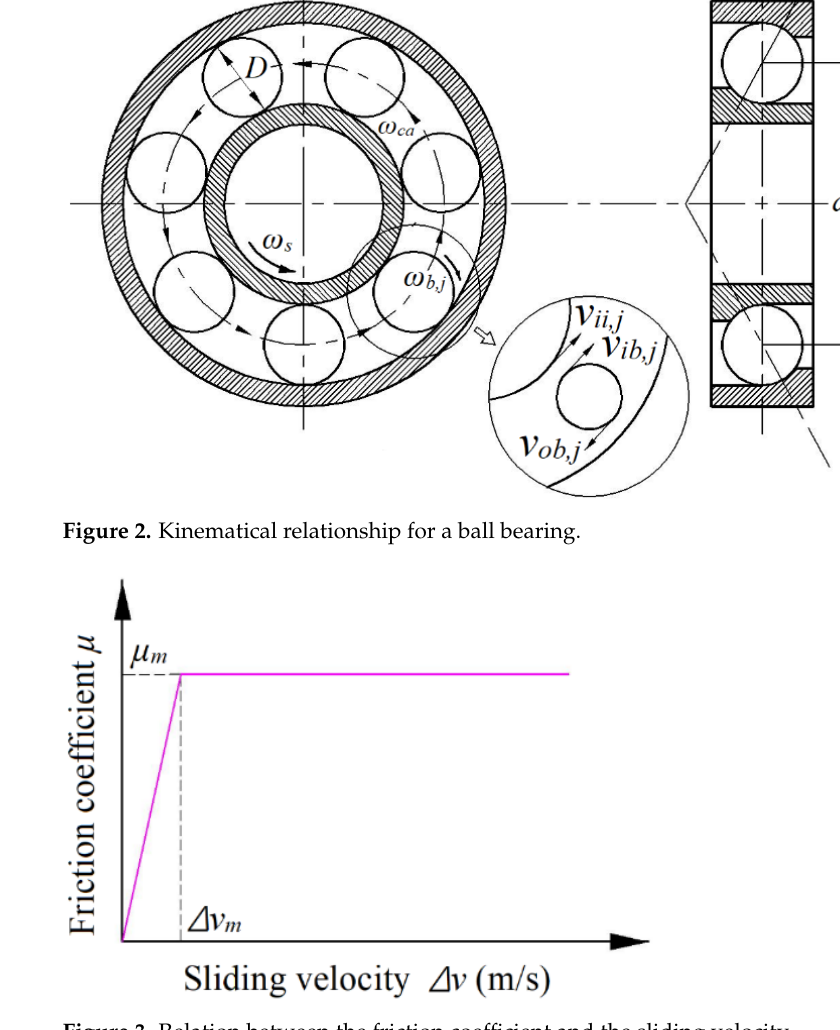
Figure 3. Relation between the friction coefficient and the sliding